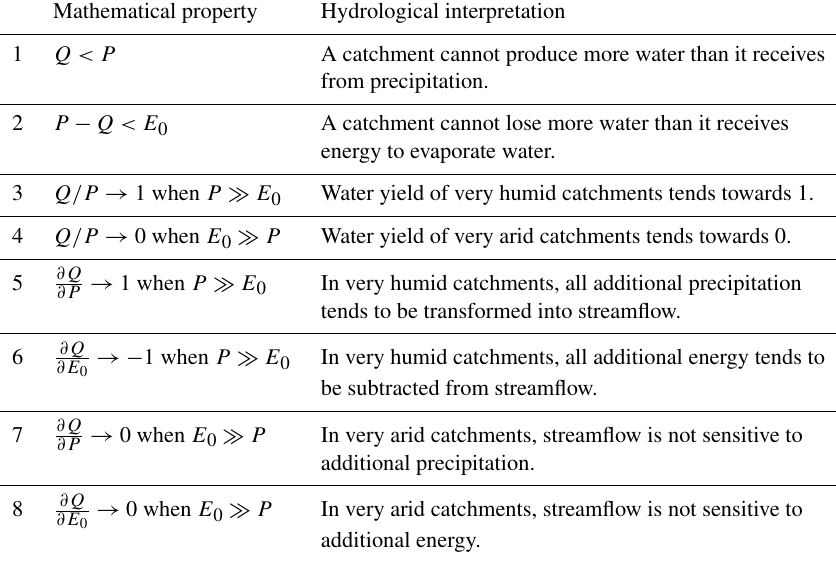
Table 4. Hydrological interpretation of the Turc–Mezentsev and Tixeront–Fu formulas, applied to streamflow ( P – precipitation, Q – stream- flow, E 0 – maximum evaporation, all in mmyr − 1 averaged over many years).